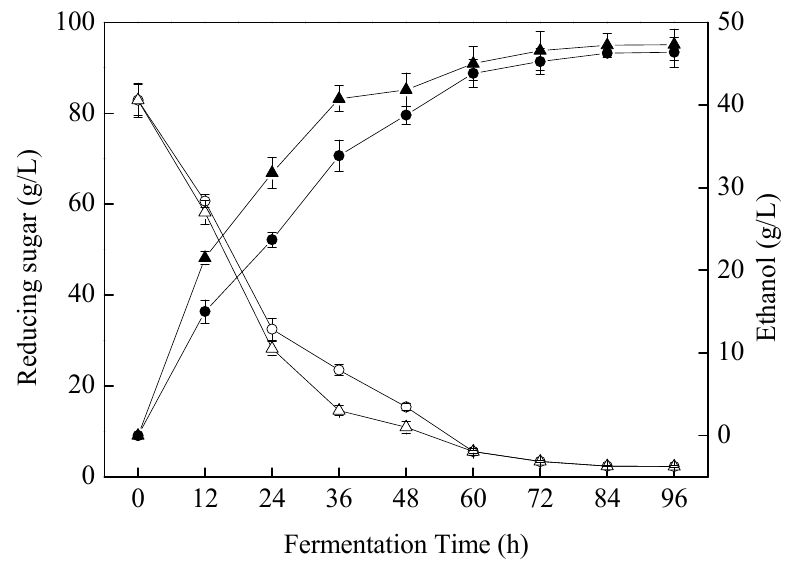
of today’s society [25].